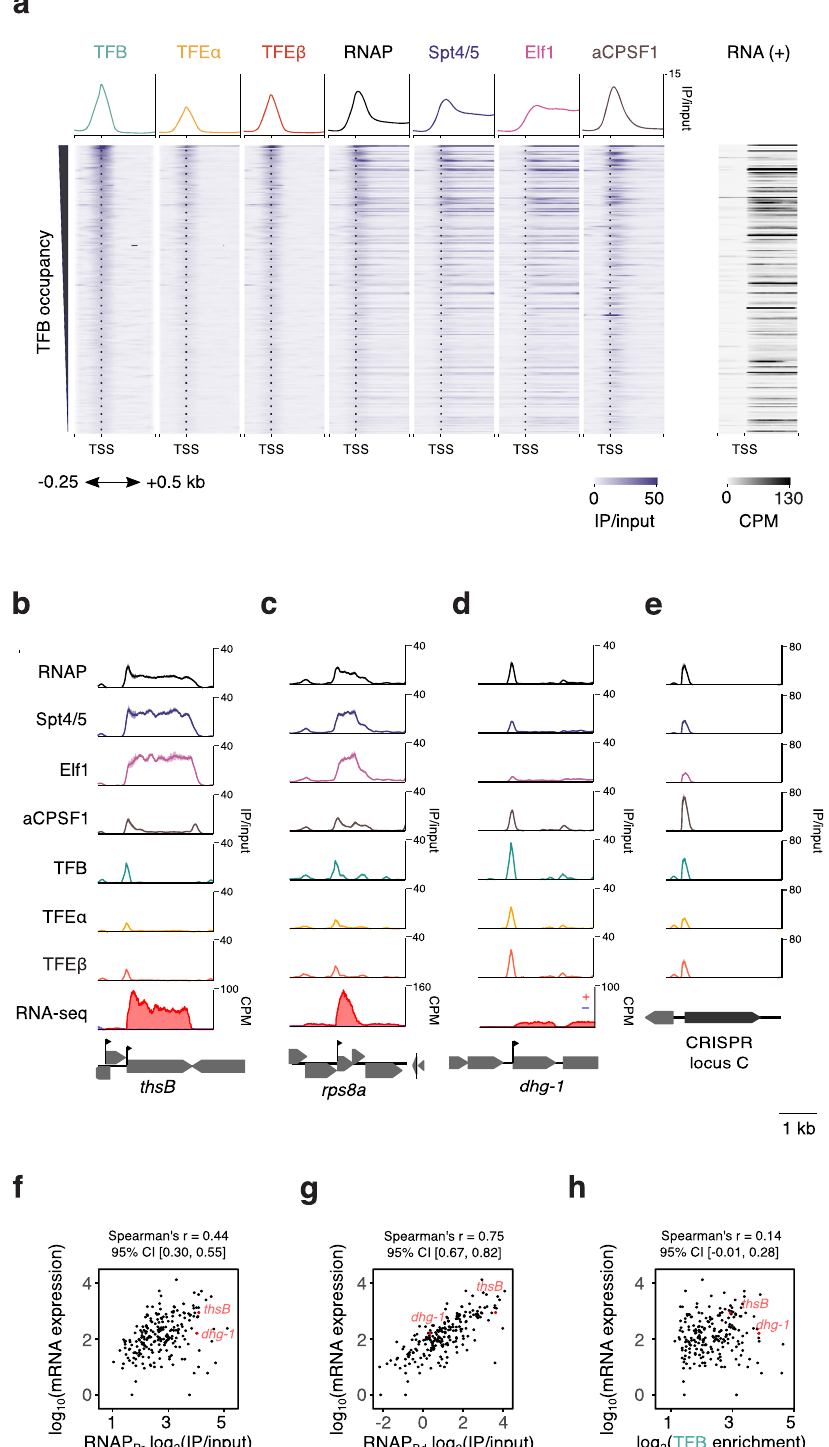
Fig. 2 Productive transcription is limited by RNAP escape. a Heatmap of ChIP-seq data for RNAP and the basal transcription machinery on a selected set of 212 TUs for exponential growth phase. The corresponding RNA-seq data for the plus strand are depicted on the right. Data are based on one representative of two biological replicates. b – e ChIP-seq occupancy plots on thsB coding for a subunit of the thermosome chaperone complex ( b ), rps8e ( c ), dhg-1 coding for a glucose-1-dehydrogenase ( d ) and CRISPR C ( e ). Traces show mean occupancy for two biological replicates with the range depicted as semi-transparent ribbon. f – h Correlation of steady-state mRNA levels with RNAP occupancy at the promoter (RNAP Pr, , f ), the TU body (RNAP Bd , g ) and TFB promoter occupancy ( h ), n = 211 TUs. ChIP-seq data represent the geometric mean of two biological replicates. Rockhopper 88 estimates of mRNA levels are based on two biological